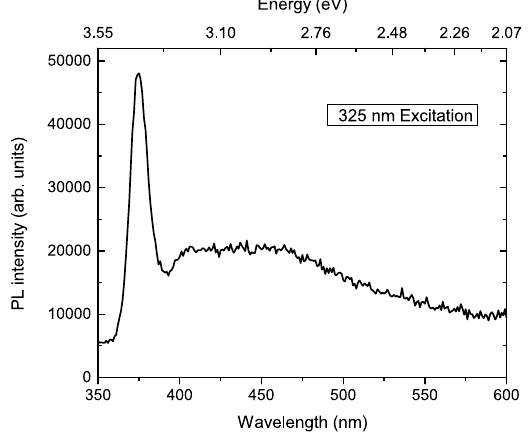
Figure 1. Typical PL spectrum of STO, after annealing and light exposure.